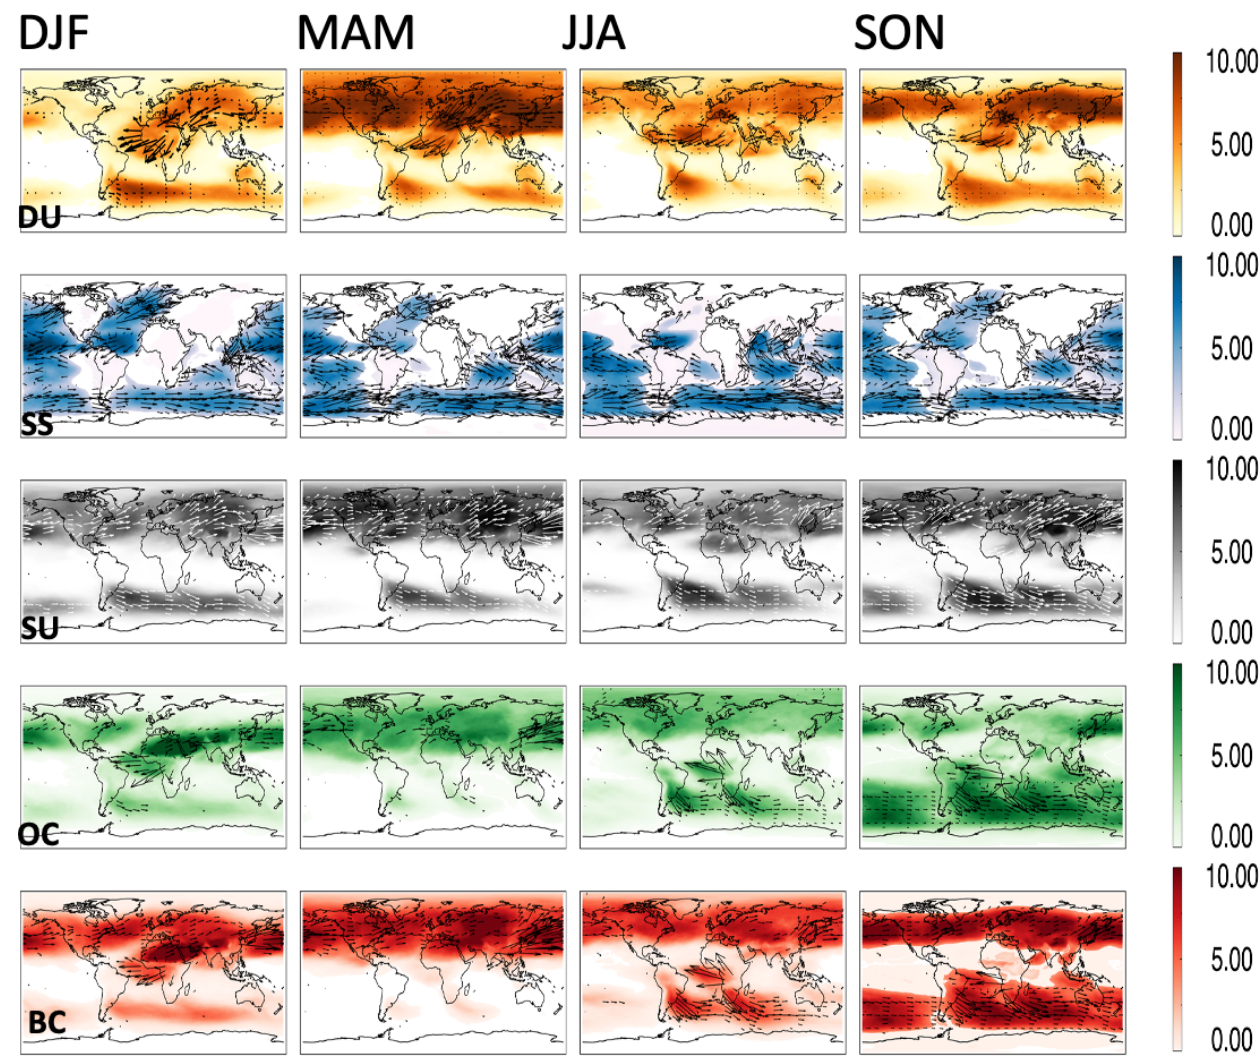
Figure 7. Seasonal variations in the AAR frequency (days per season) and IAT (arrows) for five different species of